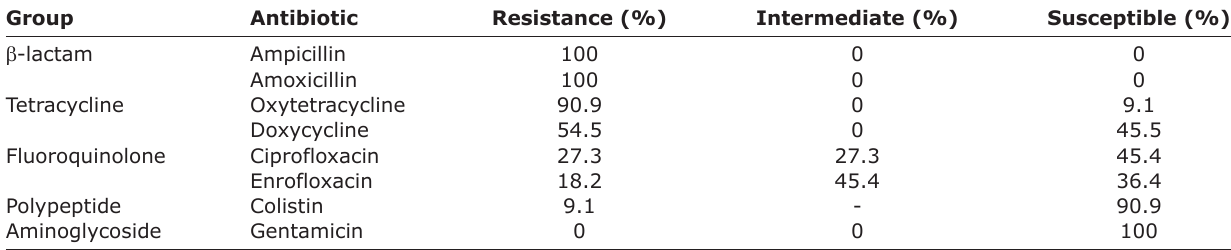
Table-3: Antimicrobial susceptibility rate of Klebsiella pneumoniae isolates. Group